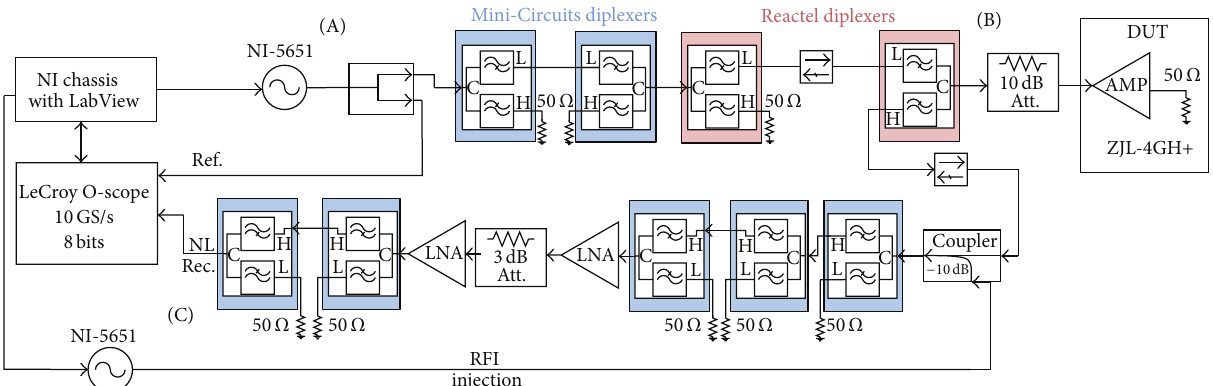
Figure 4: Block diagram of the harmonic step-frequency radar measurement system. This system is specially designed to reject unwanted self-generated interference and produce highly linearized transmit waveforms.